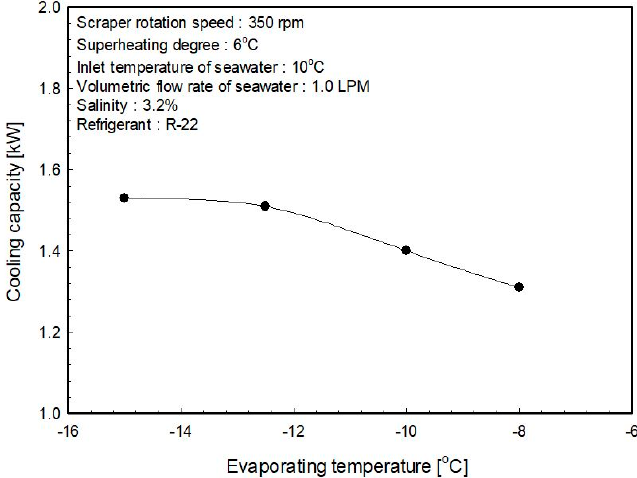
Figure 10. Cooling capacity with respect to evaporating temperature.